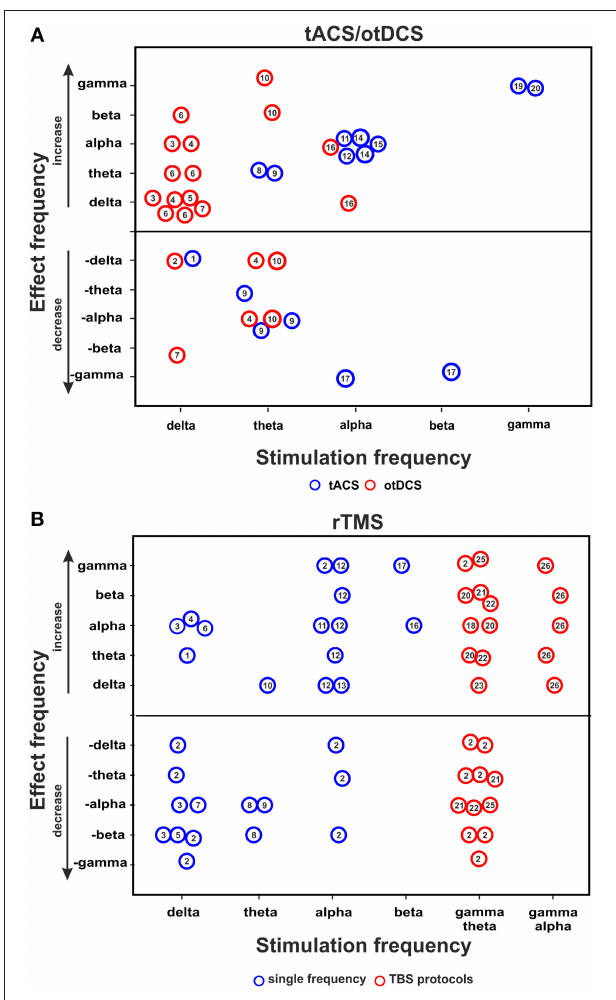
FIGURE 1 | tACS/otDCS and rTMS aftereffects on brain oscillation. Relationship between stimulation frequency and effect frequency as inferred from (A) combined tACS/otDCS-EEG/MEG studies, and (B) combined rTMS-EEG/MEG studies. The figure collapses across EEG measures used (power or coherence). Each circle represents a reported effect (refer to data in Tables 1 , 2 for tACS/otDCS and rTMS, respectively). Numbers in circles correspond to the respective study ID in the leftmost column in the relevant table. Circles above the horizontal line indicate a power/coherence increase, circles below the line indicate a power/coherence decrease. Null effects are not included; consequently this figure over-represents positive results.